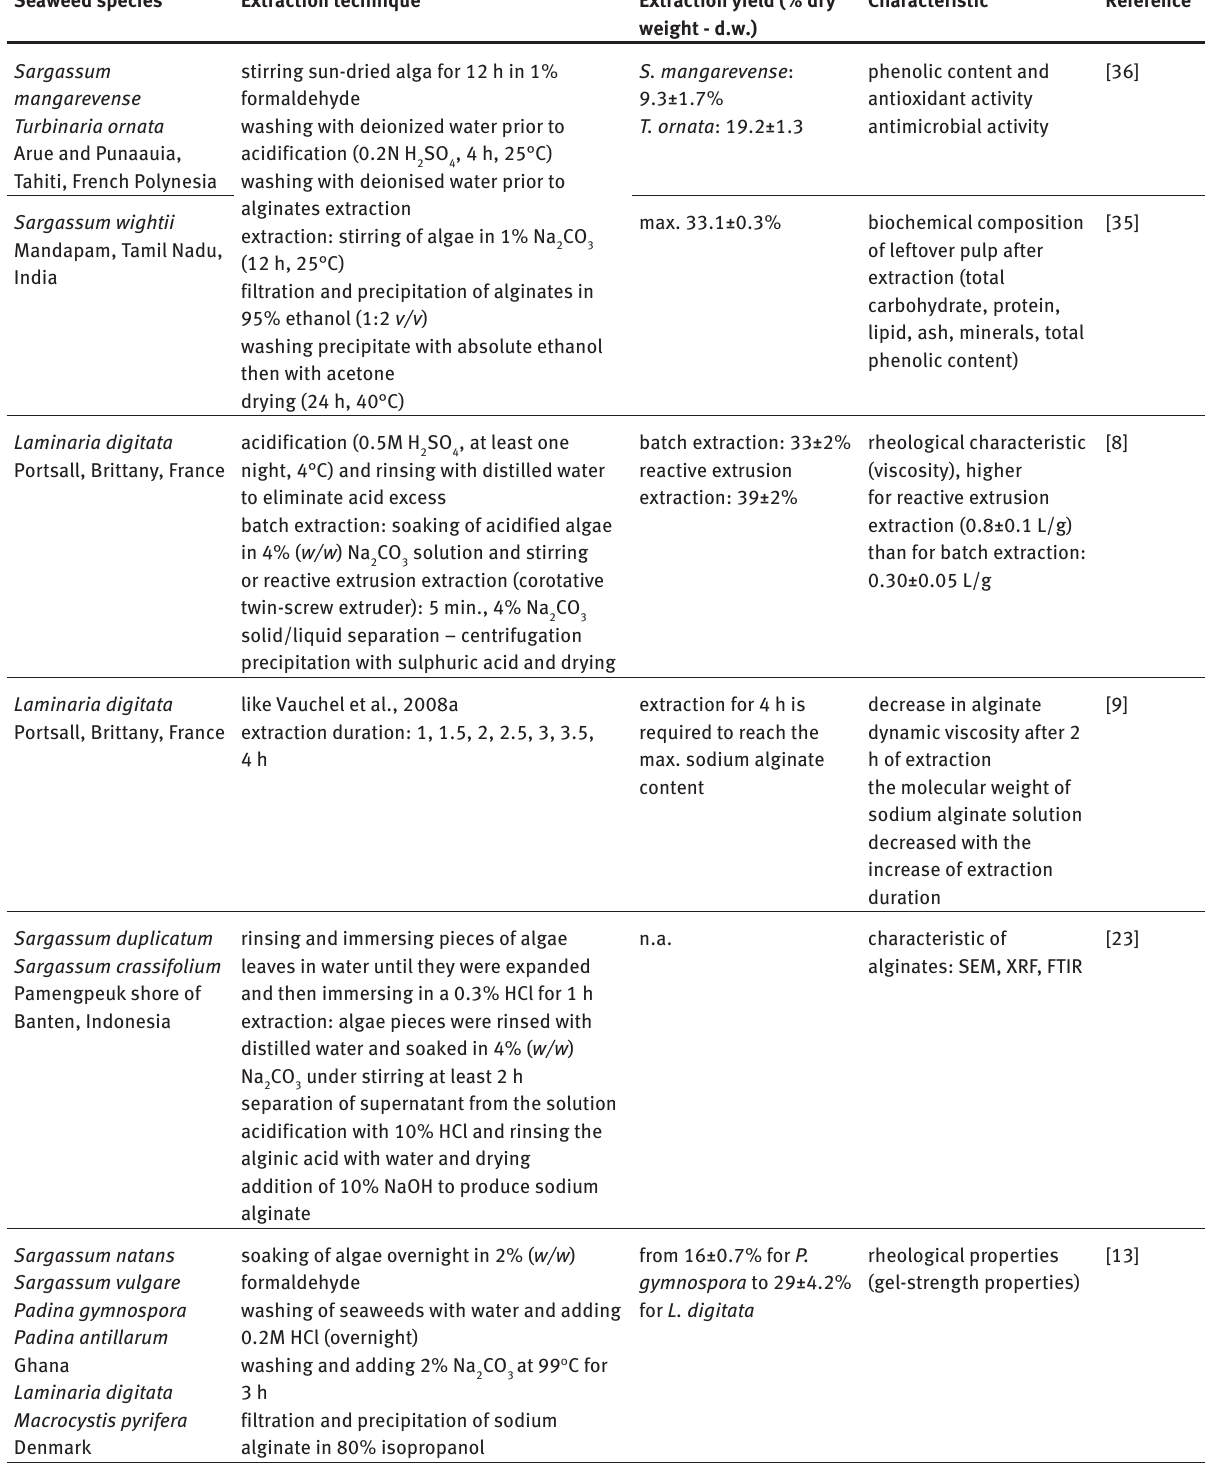
Table 1: Conventional extraction procedures of alginates. Seaweed species Extraction technique Extraction yield (% dry